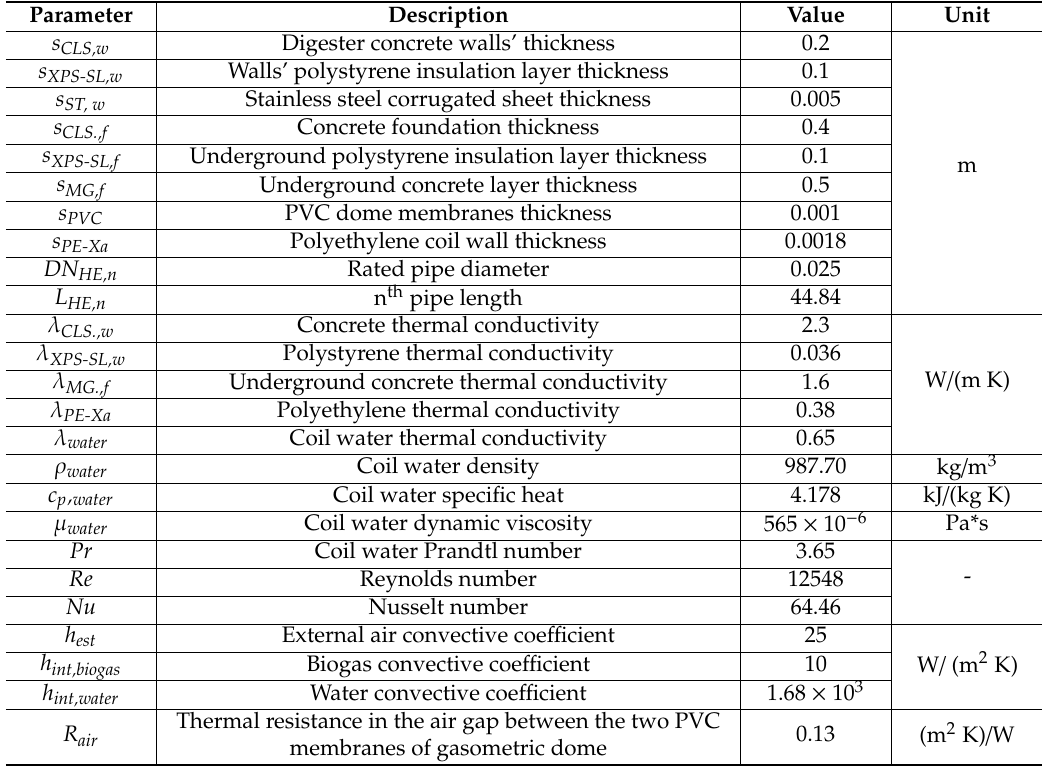
Table 6. Digester and HE structural and thermal parameters.